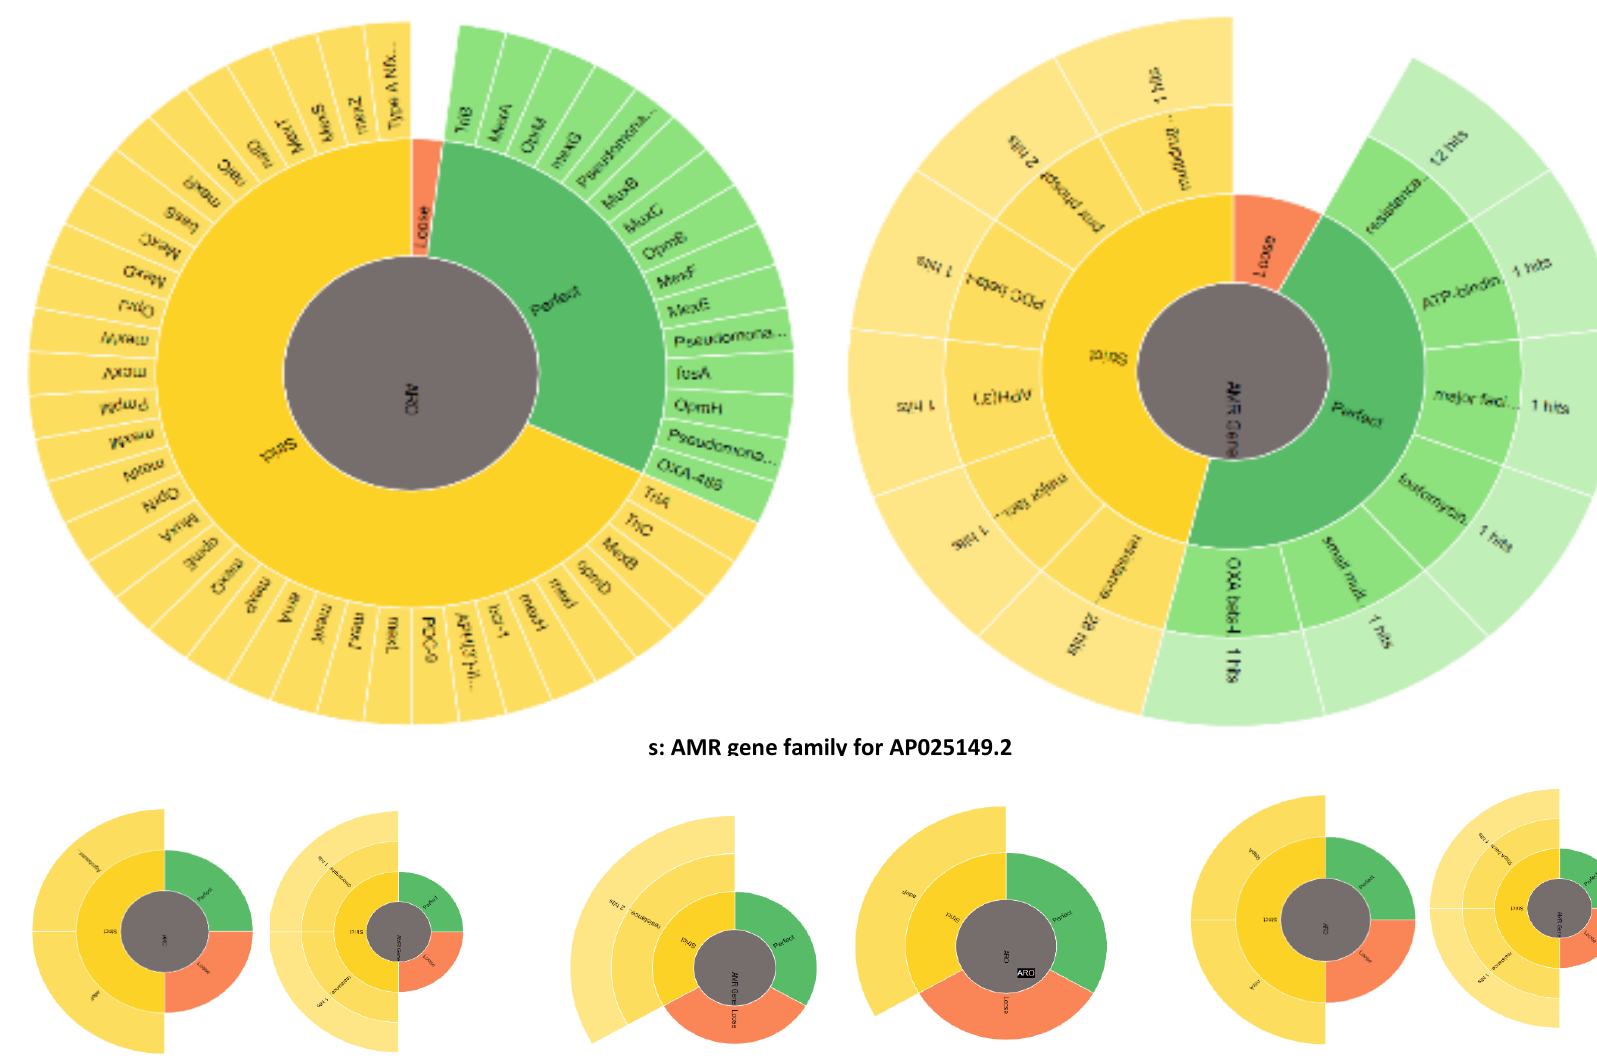
v: AMR gene family for